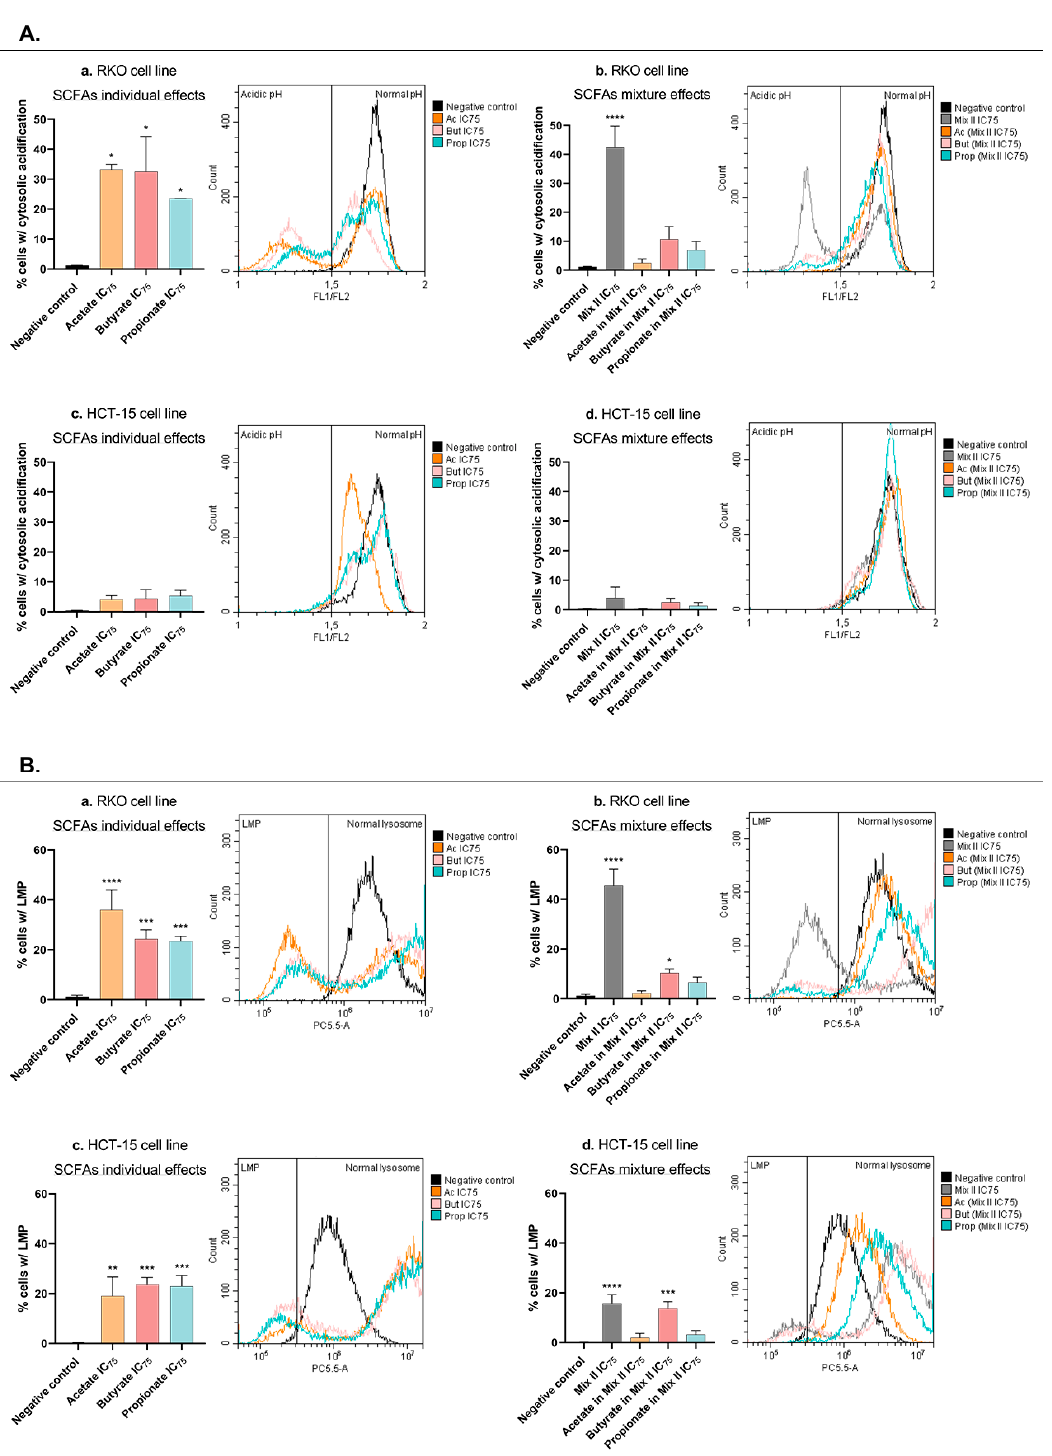
Figure 7. pH effects and LMP induced by SCFAs, individually or in mixture, in CRC cells. ( A ) Intracellular pH analysis by BCECF staining by flow cytometry in CRC cells treated with each SCFA, individually or in mixture, for 48 h. ( Aa ) RKO cells were incubated with the IC 75 of each SCFA (116.60 mM of acetate, 44.16 mM of butyrate, 56.89 mM of propionate). ( Ab ) RKO cells were incubated with the IC 75 of the mixture II, as well as the correspondent concentrations of each SCFA in that mixture (77.32 mM of Mix II containing 46.39 mM of acetate, 11.60 mM of butyrate, and 19.33 mM of propionate). ( Ac ) HCT-15 cells were incubated with the IC 75 of each SCFA (161.55 mM of acetate, 14.56 mM of butyrate, 50.70 mM of propionate). ( Ad ) HCT-15 cells were incubated with the IC 75